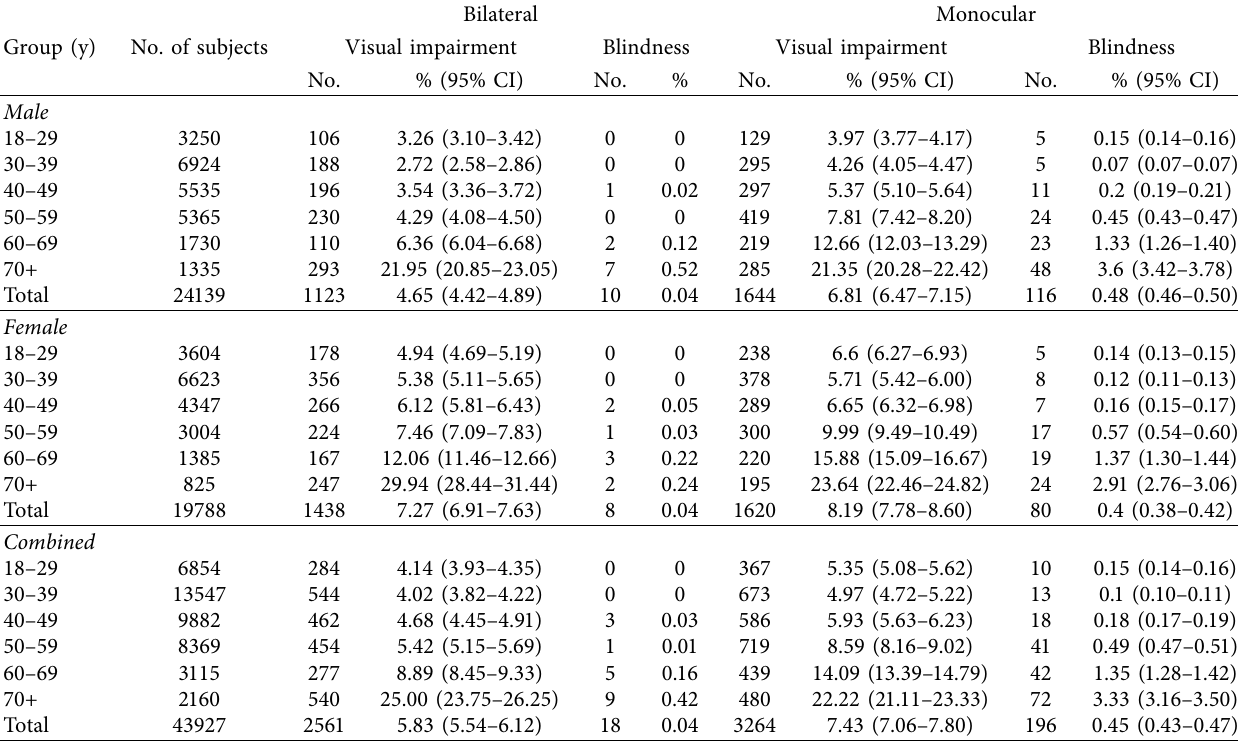
Table 2: Prevalence of presenting visual impairment and presenting blindness (United States defnition) stratifed by age and gender. Group (y)